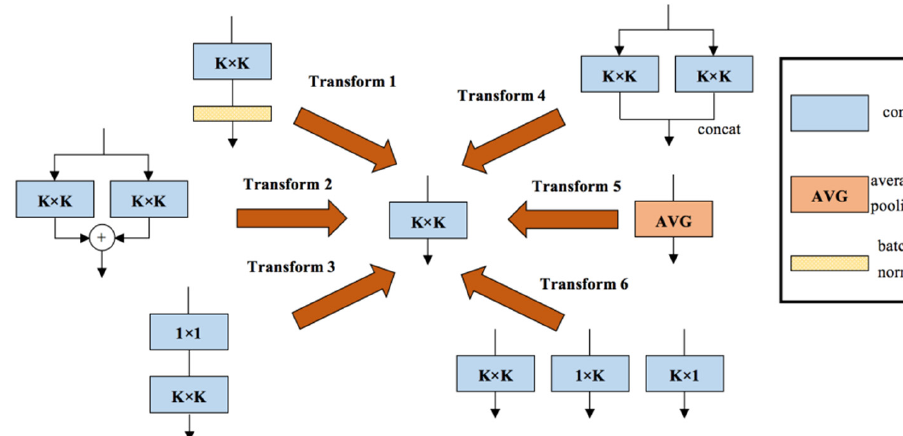
Figure 5. The six transformations included in DBB.